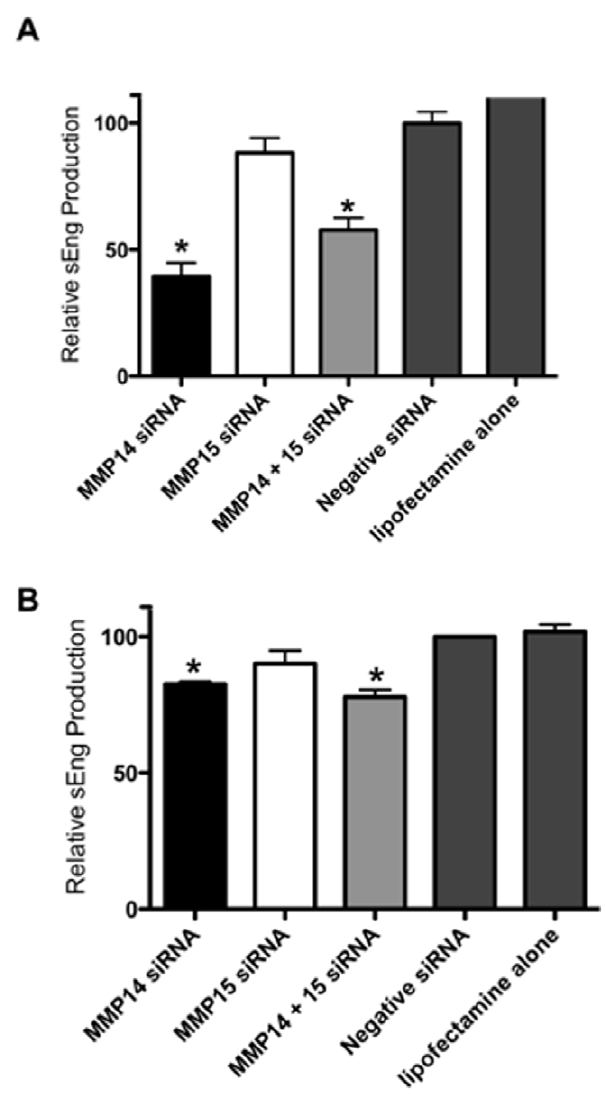
Figure 2. MMP-15 inhibtion does not decrease soluble endoglin production invitro . Treatment of HUVEC cells ( A) and syncytialised BeWo cells ( B ) with MMP-14 siRNA alone or in combination with MMP-15 siRNA induced a significant decline in sEng production compared to scrambled siRNA, whilst MMP-15 siRNA alone had no effect. Data shown as mean 6 SEM, n=3 experiments, *p # 0.05.